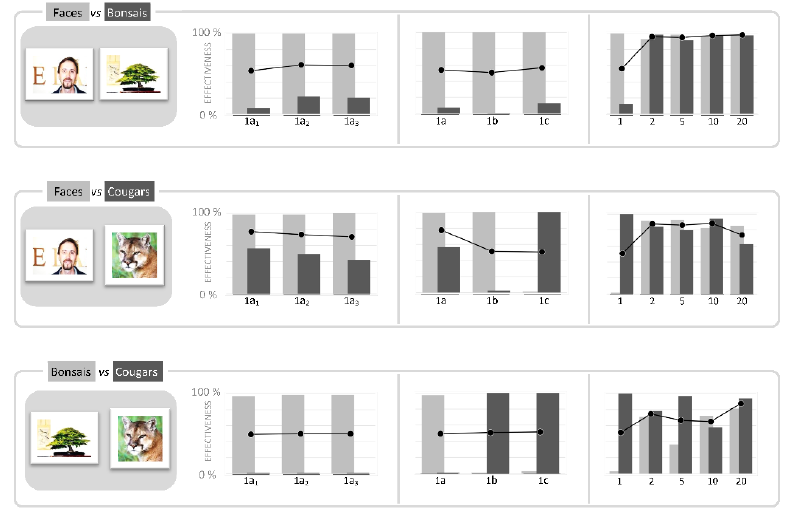
category, in percentage: the light gray bars show the success rate for the left category of each pair, while the dark gray bars show the success rate for the category on the right-hand. Each pair of bars represents the results corresponding to different training/testing conditions for HMAX. Tests and results are arranged in three groups. Tests «1a1-1a2-1a3» refer to a training operated with only one image per category, and using the same images in the three tests a1, a2 and a3. Analogously, tests «1a-1b-1c» adopted only one image per category, but used a different image in each test a, b and c. In tests «1-2-5-10-20», HMAX was trained with a larger number of images, from 1 up to 20 per category; in all these tests, each new training adopted new and different images. For all tests, training images were randomly selected among the group of images of the corresponding class.